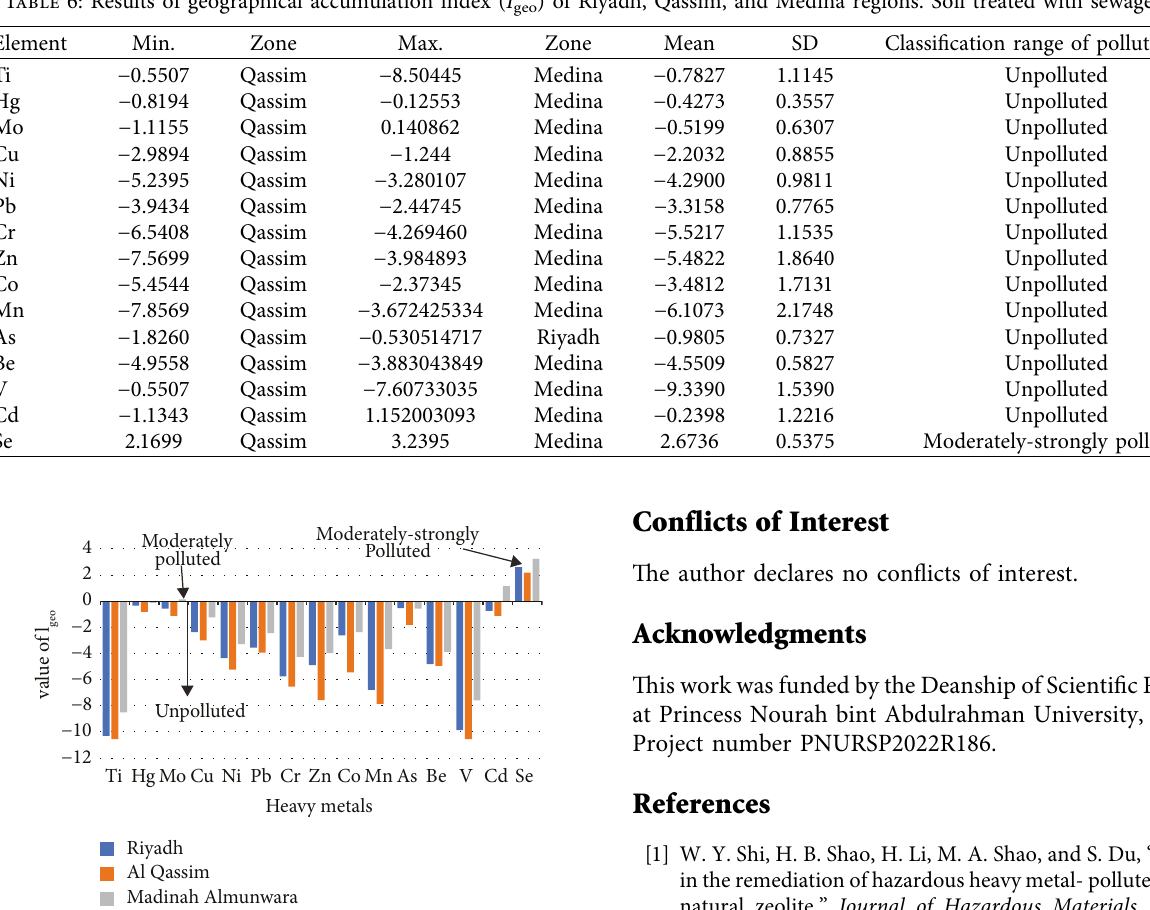
Figure 5: The value of I geo for each metal in soil of Riyadh, Medina, and